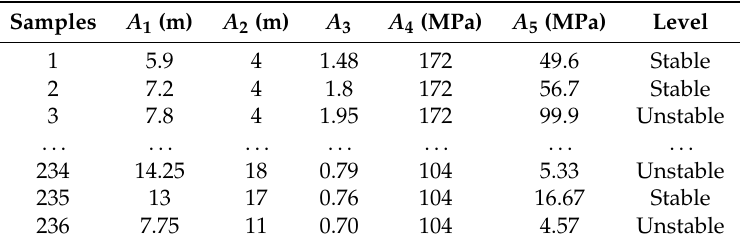
Table 1. Pillar stability data.